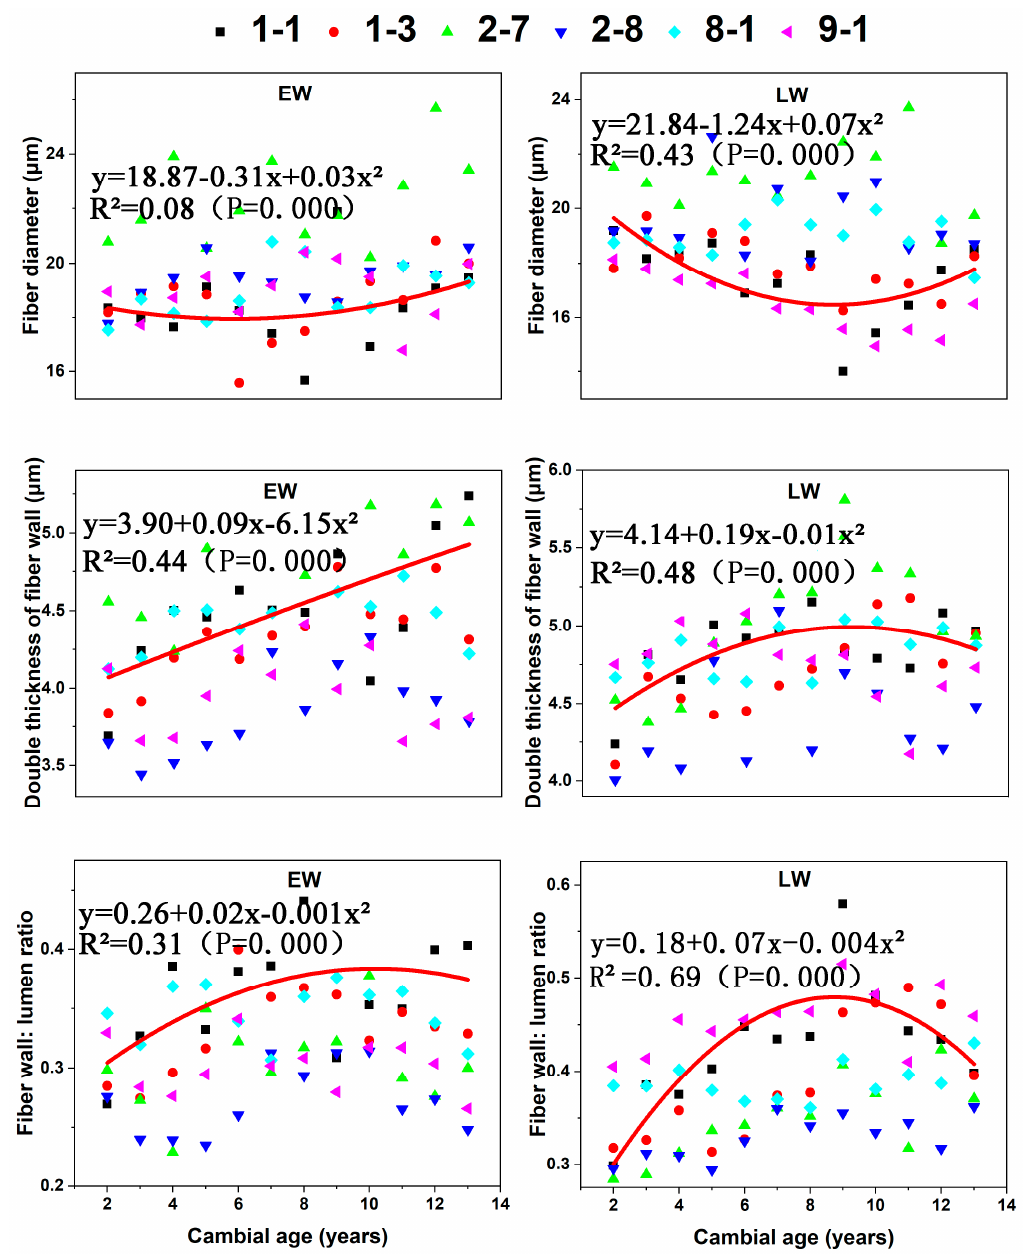
Figure 6. The fiber characters in both earlywood (EW) and latewood (LW): fiber diameter, double thickness of fiber wall, and fiber wall: lumen ratio for the six C . bungei clones versus cambial age. There were pronounced e ff ects of age on the double thickness of cell wall ( R 2 = 0.44 for EW and 0.48 for LW). Thickness significantly increased with cambial age in EW. In contrast, thickness increased until the eighth year and then remained stable in LW. The fiber wall: lumen ratio increased from the pith to the eighth year and then remained stable in EW and decreased from the eighth year to the bark in LW. Radial variation in LW ( R 2 = 0.69) was more pronounced than in EW ( R 2 = 0.31). Vessel length in LW, vessel diameter in EW, and the number of vessels in EW varied significantly from the pith to the bark (Figure 7). Variation in vessel length in EW, vessel diameter in LW, and the number of vessels in LW was not radially significant. Variation in the radial pattern was